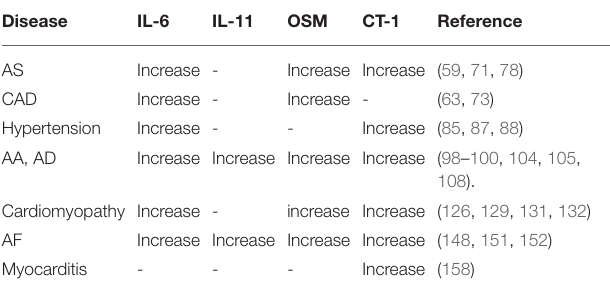
TABLE 2 | The expression of IL-6 family members on cardiovascular